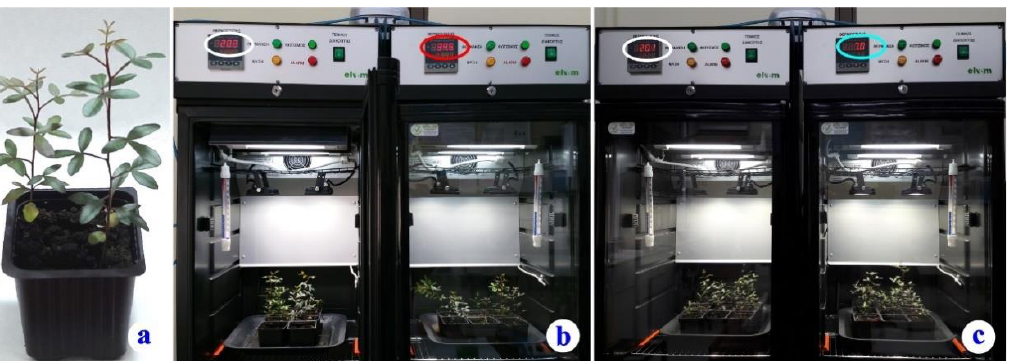
Figure 7. ( a ). One of the pots with two P. lentiscus plantlets, at the beginning of the experiment. ( b ) Two of the culture chambers during the heat stress. The control chamber, at the left, and the heat-stress chamber, at the right. Note the temperature reading (34.5 ◦ C) at the moment of the snapshot. ( c ) Two of the culture chambers during the cold-stress experiment. Note the temperature reading (7.0 ◦ C) at the right